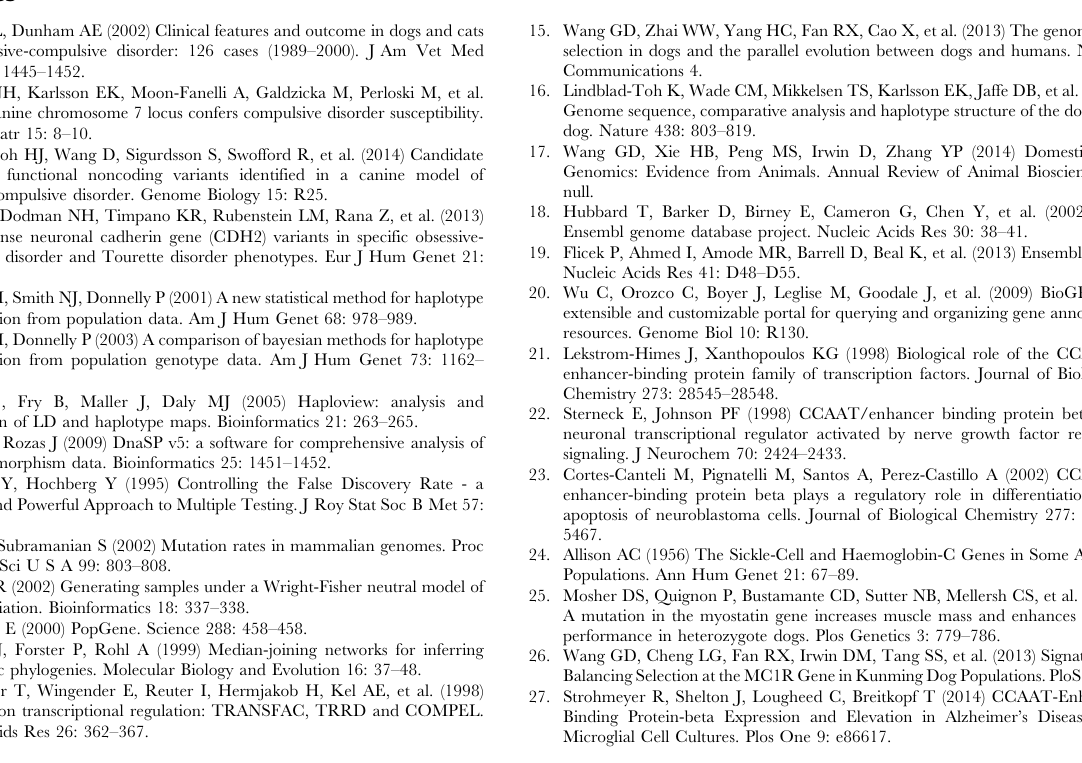
Figure S1 Frequency spectrums of polymorphic sites in two populations. (A) Frequency spectrums of polymorphic sites in BM population. (B) Frequency spectrums of polymorphic sites in CID population. (PDF) Figure S2 LD distribution in the CDH2 gene of the CID population. (PDF) Figure S3 Demographic history of dogs and wolves before 10,000 years ago estimated by PSMC. (PDF) Sequence S1 The sequences of segment S8 which is shorter than 200bp.